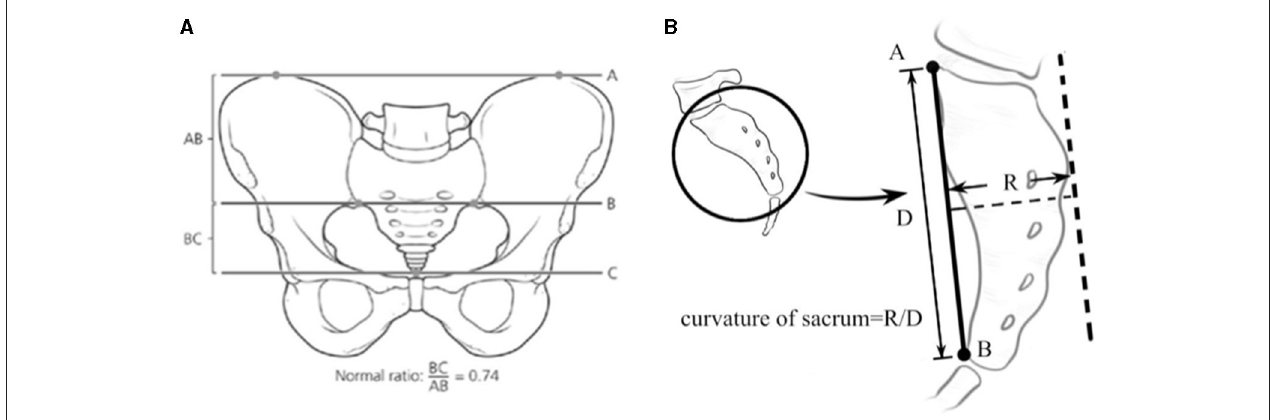
FIGURE 1 | (A) The calculation of SR (6). (B) the measurement of